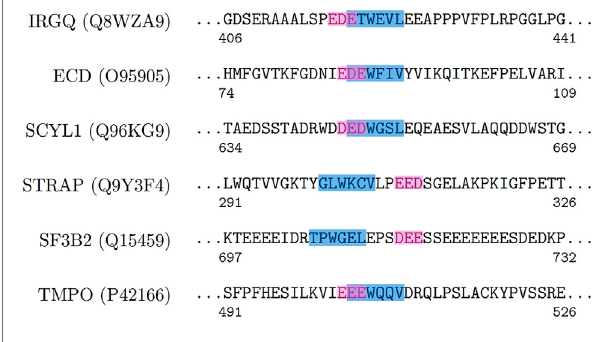
FIGURE 2 | An analysis of the sequence-proximity of the triacidic motif with the LIR motif among some of the proteins from the class I of the UCPS- ATG data set is